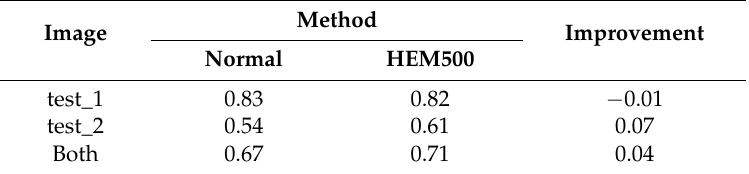
Table 5. Average F1 score and improvement of each test image in the case of ×